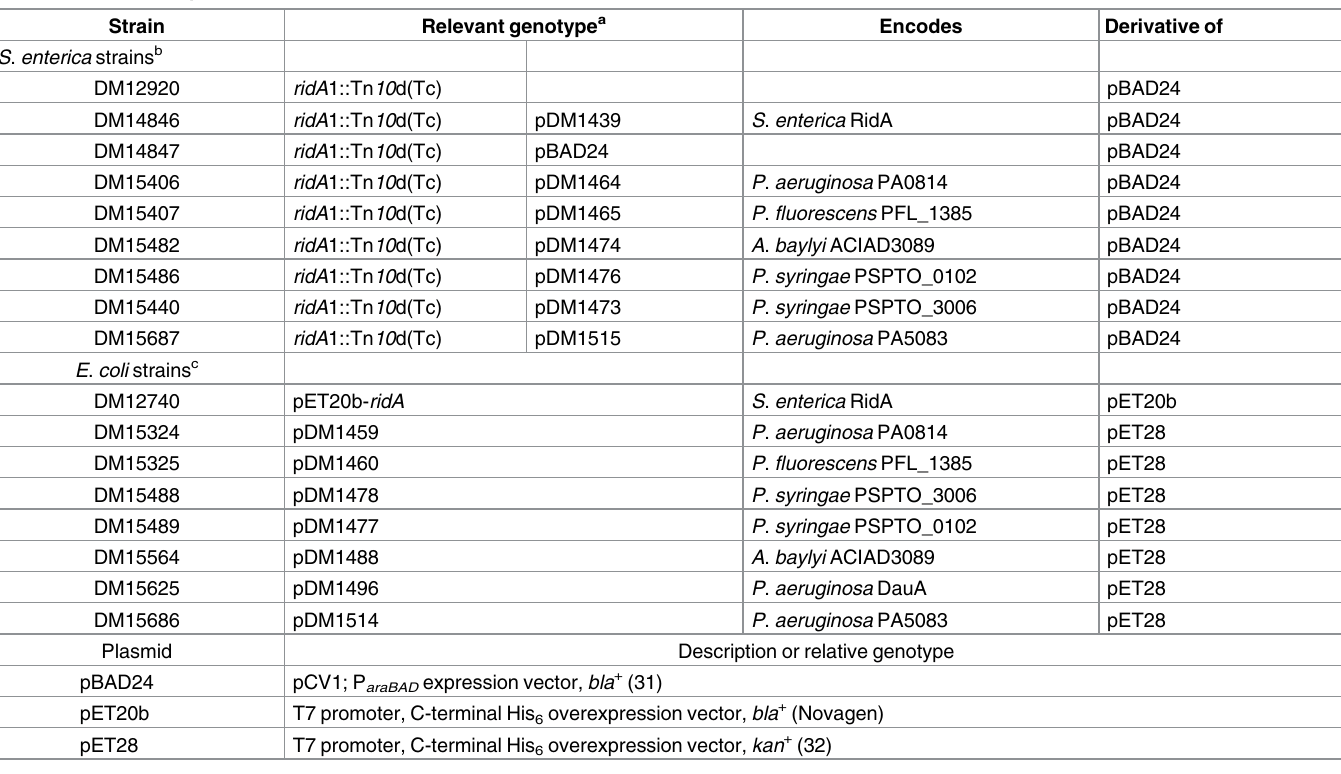
Table 1. Strains and plasmids.